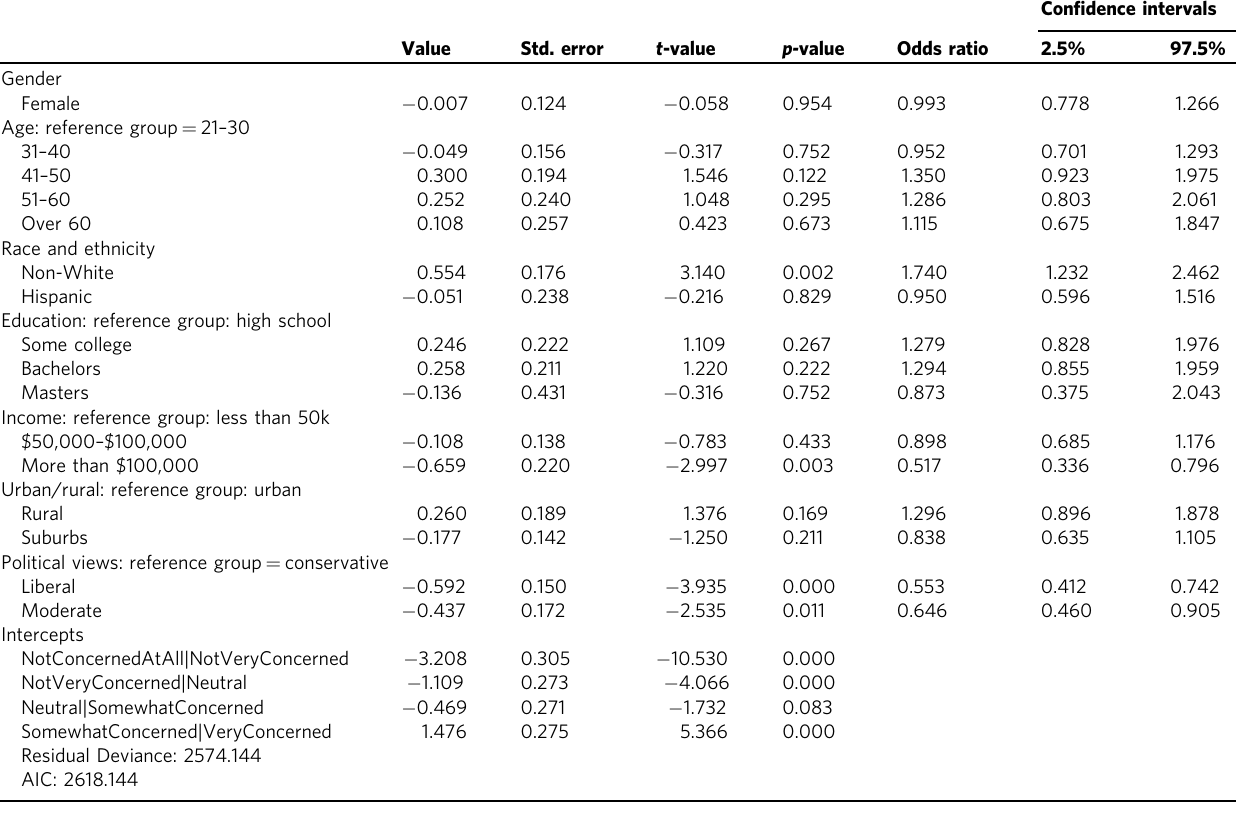
Table 4 Ordered logistic regression model estimates of the public ’ s perception of security.